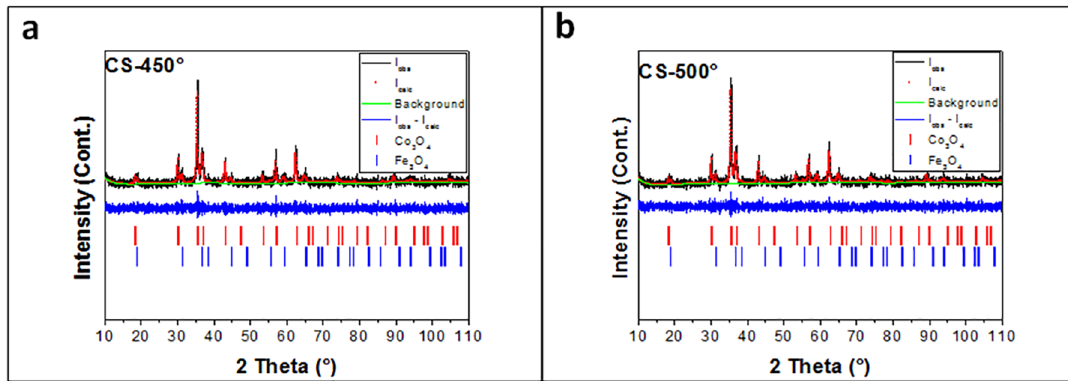
Figure 4. X-ray diffraction (XRD) measurement and Rietveld refinement of the samples: a) CS-450. b)